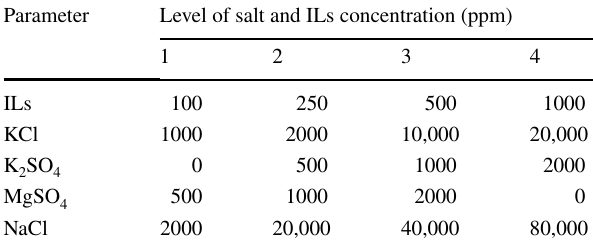
Table 4 Effective parameters and their concentration in various levels of experiment Parameter